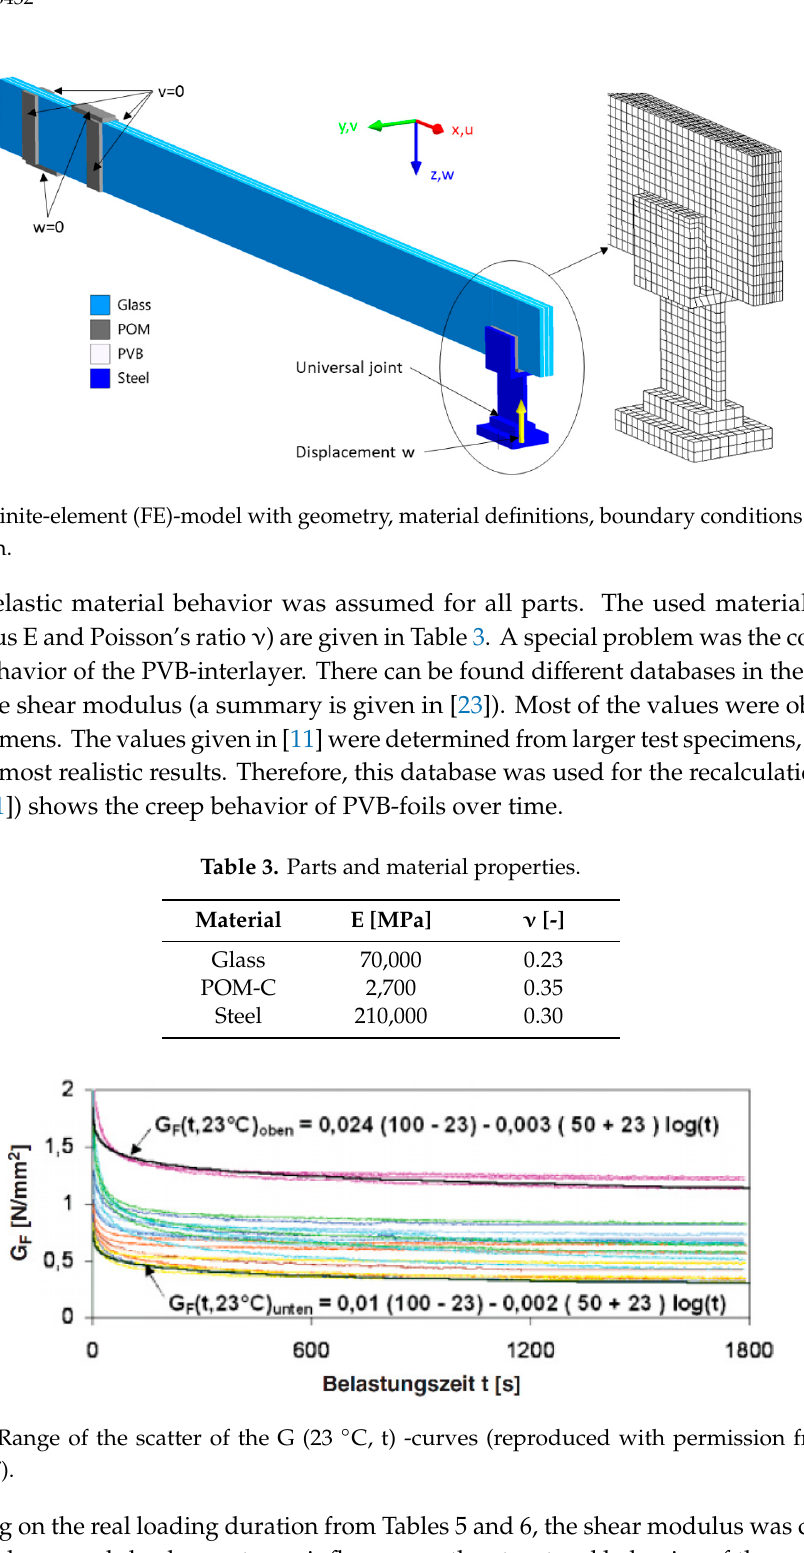
( b ) Figure 5. Exemplarily some results from the numerical simulations: ( a ) Lateral displacements v (mm, in y -direction), ( b ) maximum principal stress (MPa).